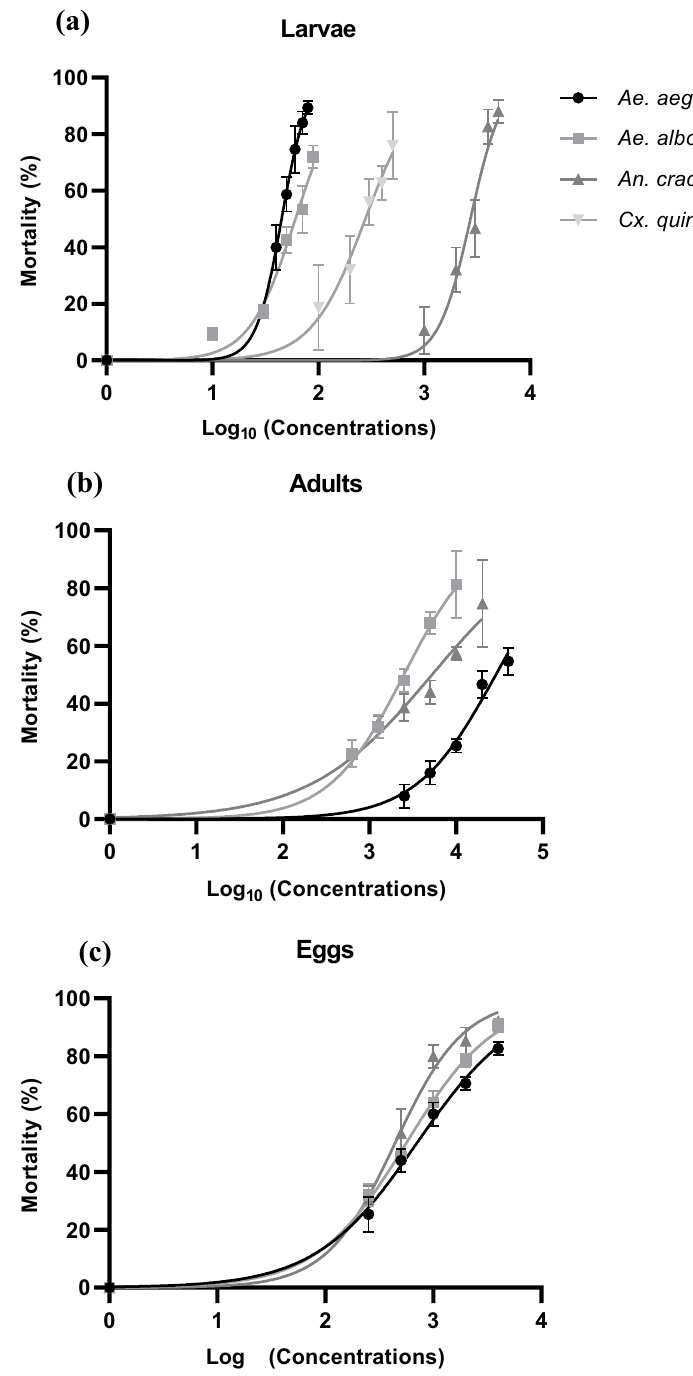
Figure 2. Concentration- and dose–response curves generated from the mean percentage mortality after 24 h exposure to various concentrations of Streptomyces sp. KSF103 EA extract for: ( a ) larvae of Ae. aegypti , Ae. albopictus , An. cracens , and Cx. quinquefasciatus ; ( b ) female adults of Ae. aegypti , Ae. albopictus , and An. cracens ; and ( c ) eggs of Ae. aegypti , Ae. albopictus , and An. cracens